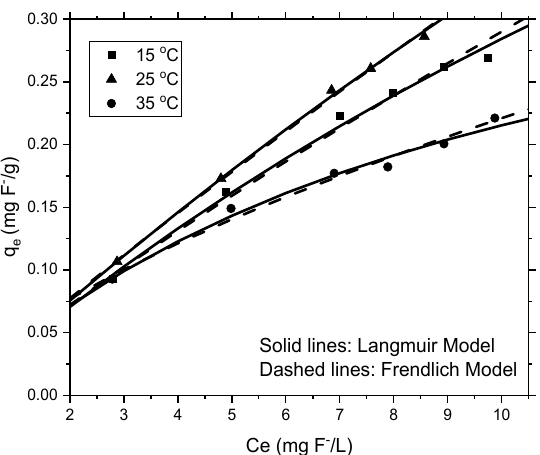
Solid lines: Langmuir Model Dashed lines: Frendlich Model